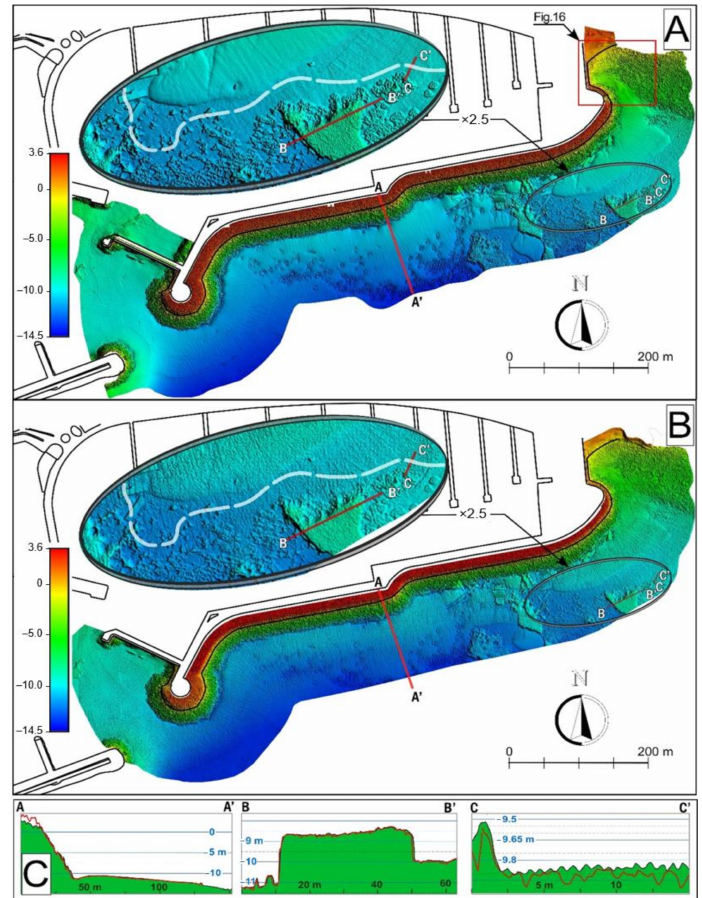
Figure 15. Morpho-bathymetry of the study area related to the two surveys: ( A ) February 2019; ( B ) November 2019. The zooms in ( A ) and ( B ) show the high detail of the acquisition; the white dotted line indicates the upper limit of the Posidonia oceanica seagrass after [58]. The red lines indicate the sections reported in ( C ), where the black and red lines refer to February and November 2019, respectively. The red box in ( A ) indicates the location of the zoom reported in Figure 16.